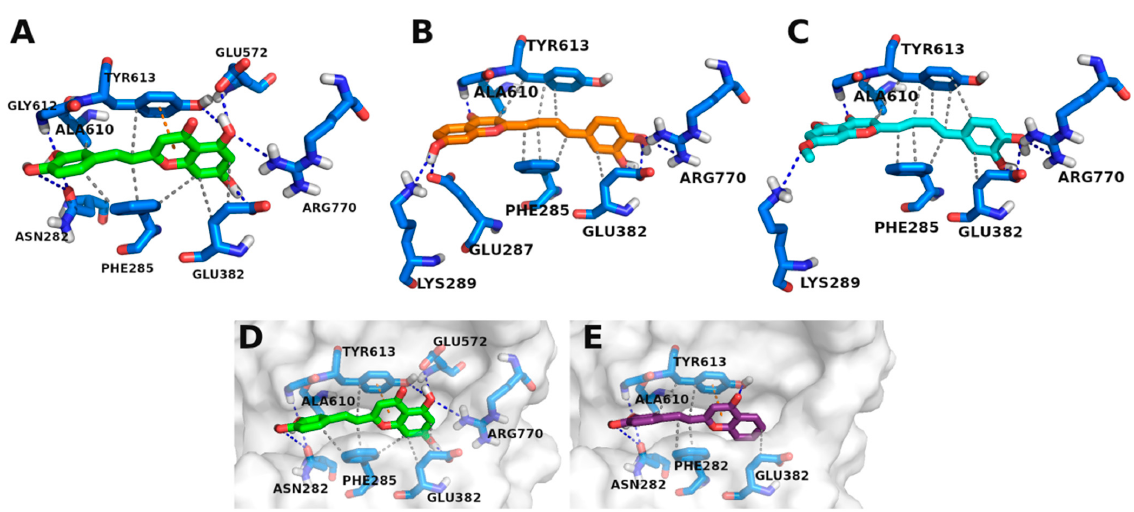
Figure 5. Placement of 2-styrylchromones and 2-styrylchromone-related derivatives in the inhibitor binding site of GPa. ( A ) Compound 23 (green) and the GPa residues it interacts with. ( B ) Compound 32 (orange) and the GPa residues it interacts with. ( C ) Compound 33 (cyan) and the GPa residues it interacts with. ( D ) Compound 23 (green) versus ( E ) compound 18 (purple) in the inhibitor binding site. Bond types are encoded as follows: hydrophobic interactions (grey), hydrogen bonds (blue), pi-stacking (orange). Nutrients 2021 , 13 , x FOR PEER REVIEW